Question: Produce a descriptive caption suitable for publication.
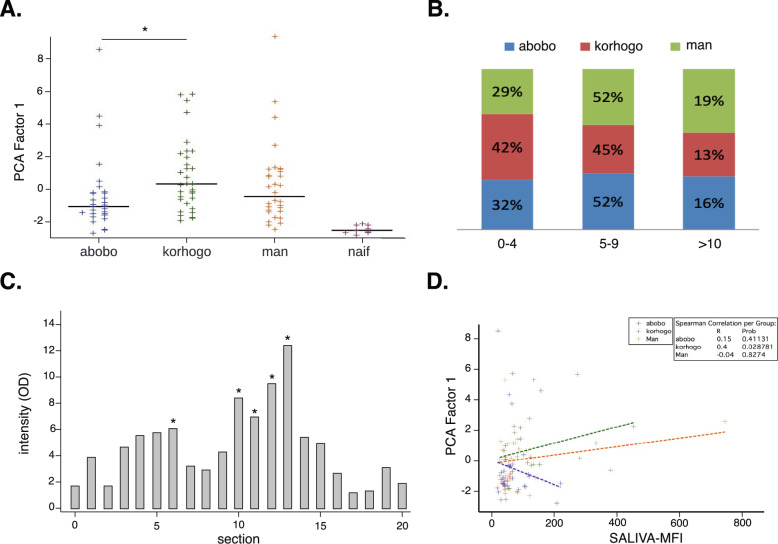
Answer: Pattern of brain self-reactive IgG response and correlation with saliva response in the different sentinel sites. A PCA factor 1 score from adjusted IgG reactivity profiles in the sentinel sites. Groupwise distribution of PCA factor 1 score. B Distribution of brain antigenic bands recognized in Abobo, Korhogo, and Man. C Mean OD intensity by section; asterisks indicate sections significantly differing between sites by Kruskal–Wallis test. D Relationship between self-reactive IgG and saliva IgG response according to the study site